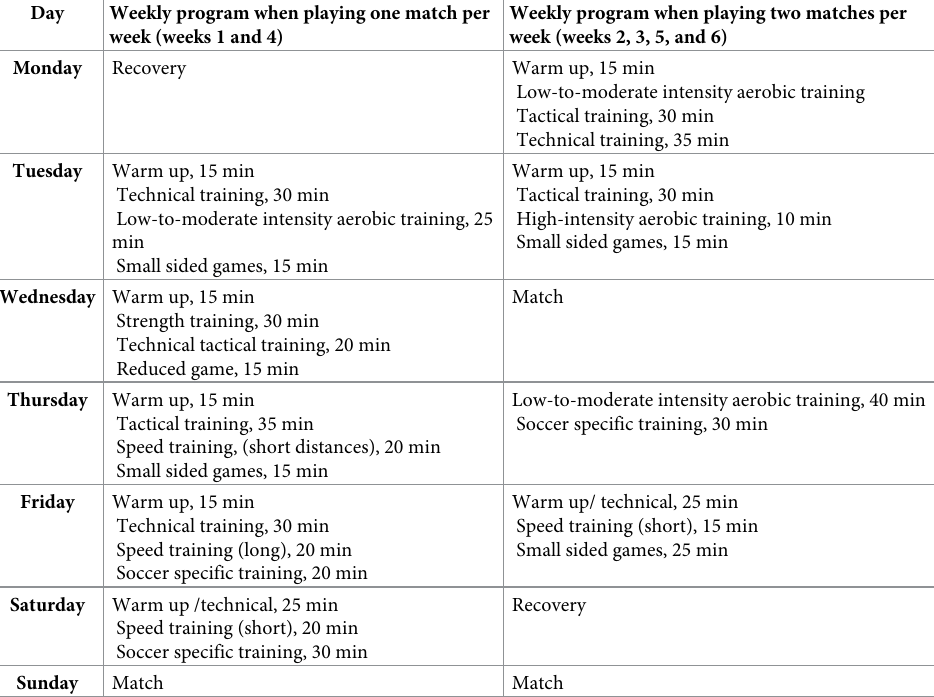
Table 1. Training program during the congested